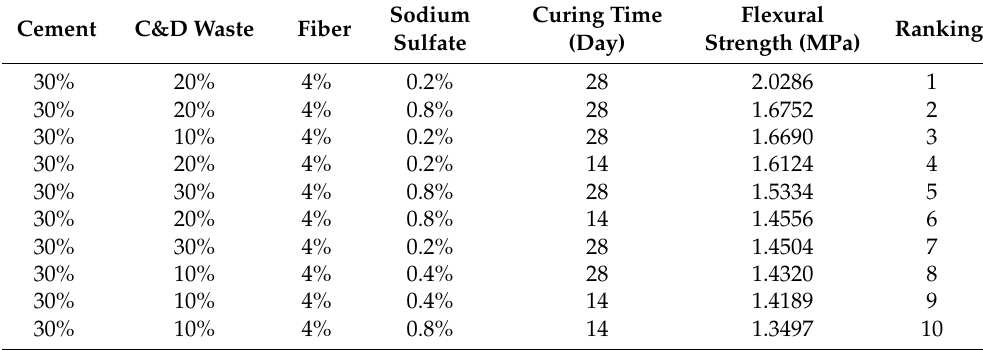
( b ) Figure 10. Microstructure of polypropylene fiber: ( a ) untreated fiber; ( b ) alkali-treated fiber.